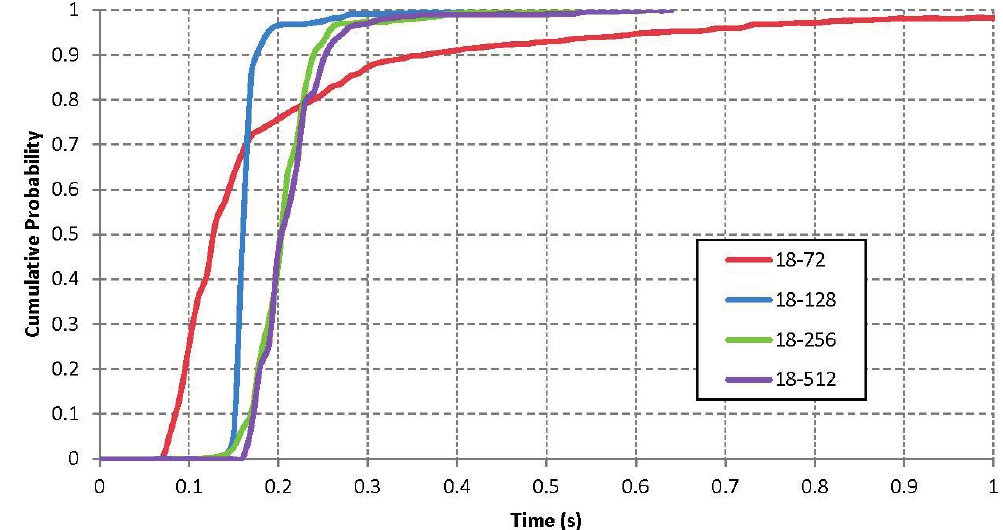
Figure 7. Remote Name Request time